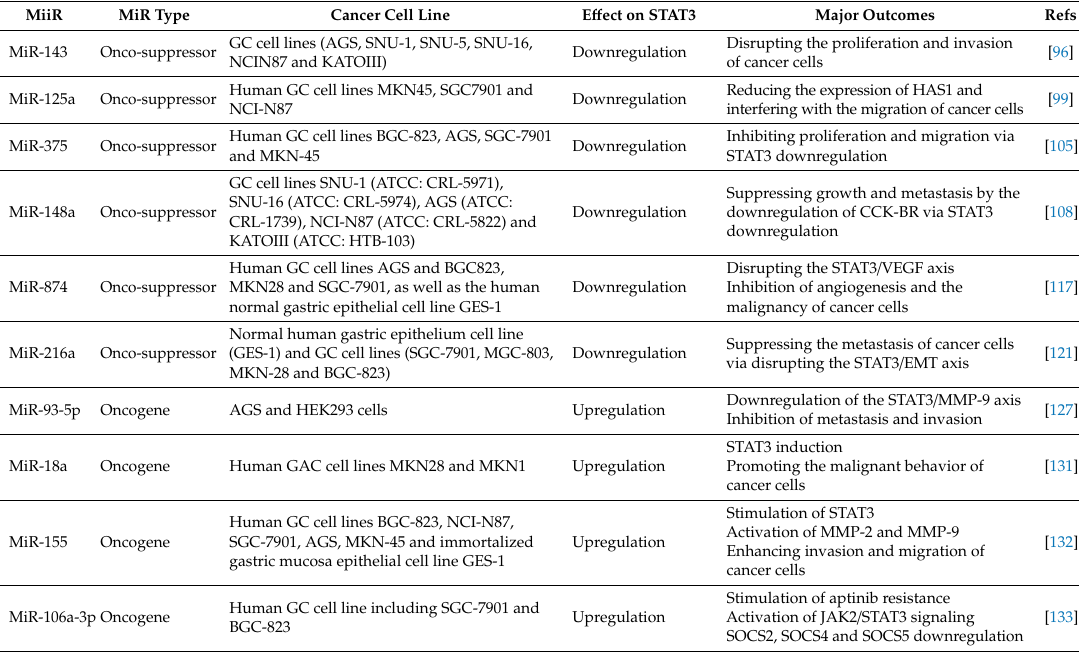
Table 3. The regulation of STAT3 by miRs in gastric